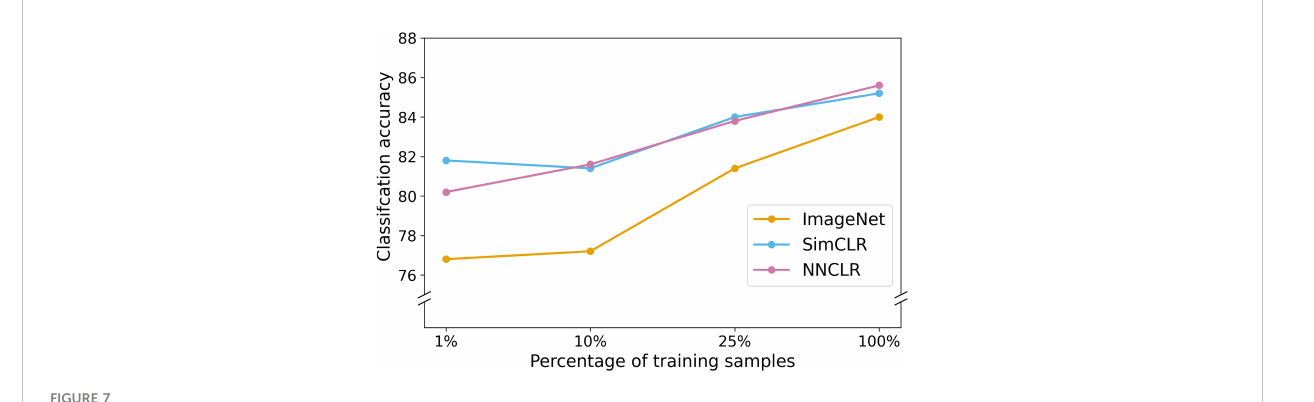
FIGURE 7 Classi fi cation accuracy versus percentage of training samples for three types of weight